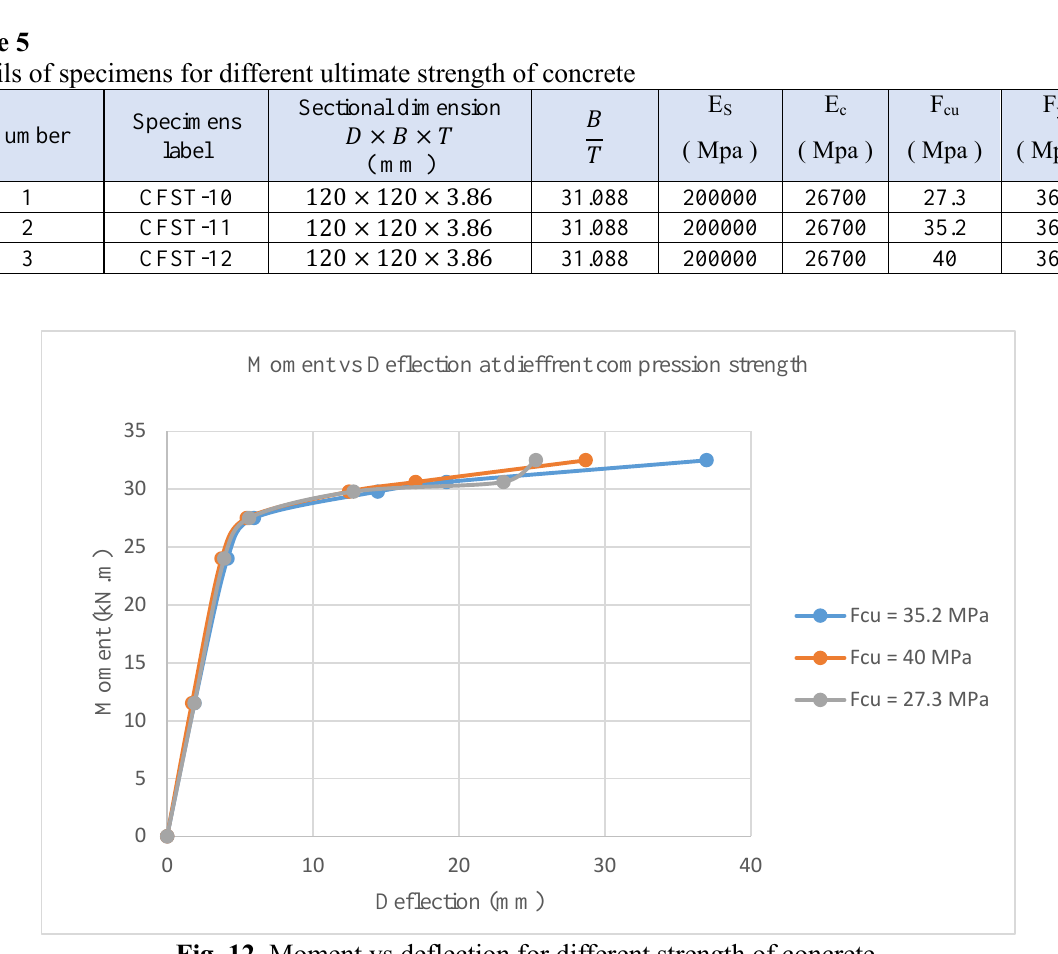
Fig. 12. Moment vs deflection for different strength of